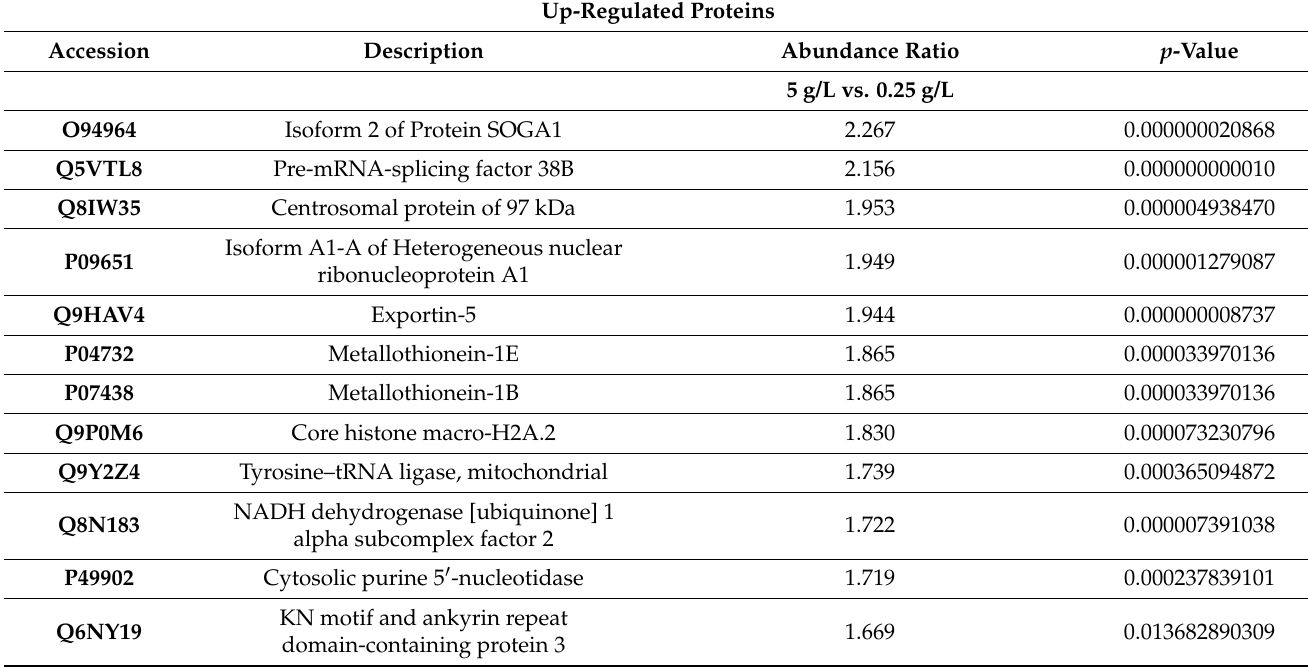
Figure 8. Network of up-regulated proteins in HMEC-1 exposed to urea. The network, obtained with the software STRING, includes proteins that were found to be up-regulated in cells treated with 5 g/L urea compared to cells treated with 0.25 g/L urea for 72 h.